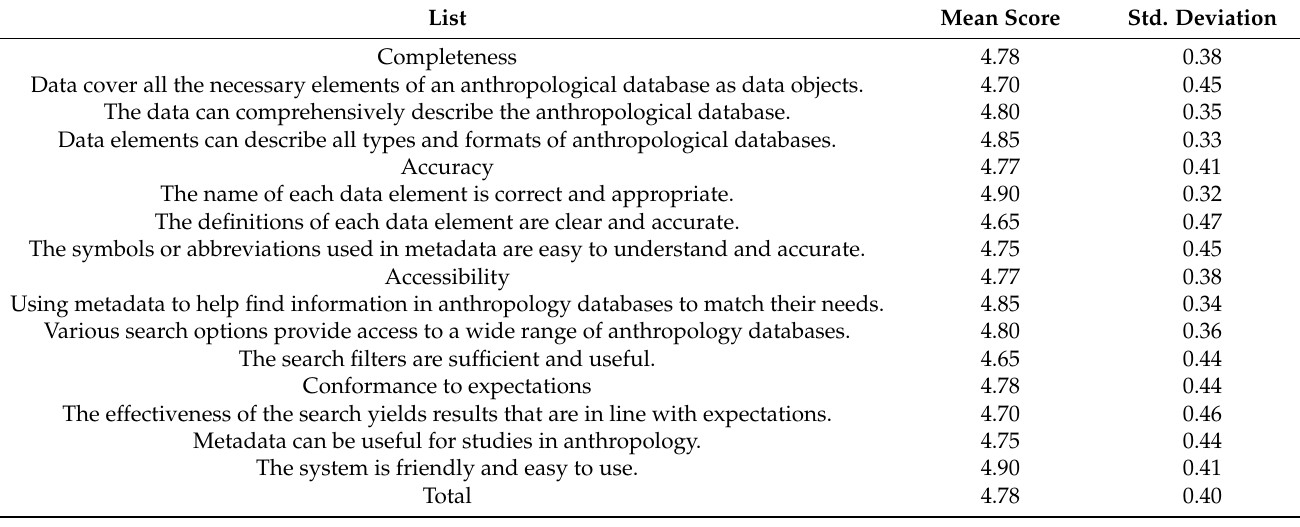
Table 5. Result of metadata